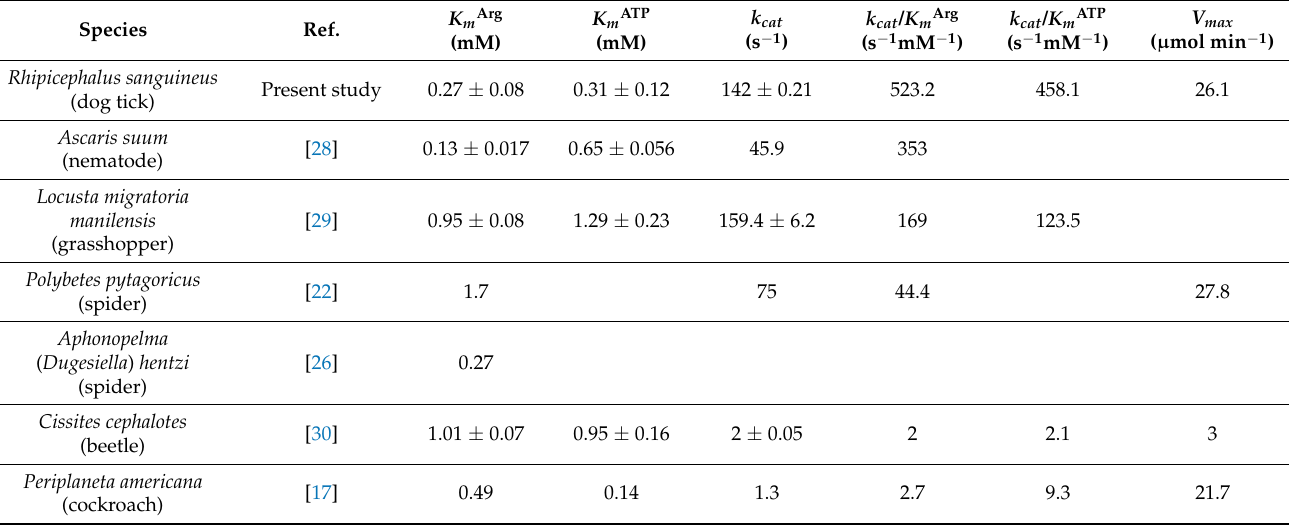
Figure 1. Michaelis-Menten plots of Rs AK kinetics with L-arginine and ATP substrate. ( A ) represents the kinetics with L-arginine. The final concentrations of L-arginine varied from 0.078 mM to 7.5 mM. ( B ) represents the kinetics with ATP. The final concentration of ATP ranged from 0.05 mM to 6.5 mM. Data is described as means ± standard deviation of experimental triplicates. Table 1. Comparison of kinetic constants of invertebrate AKs.